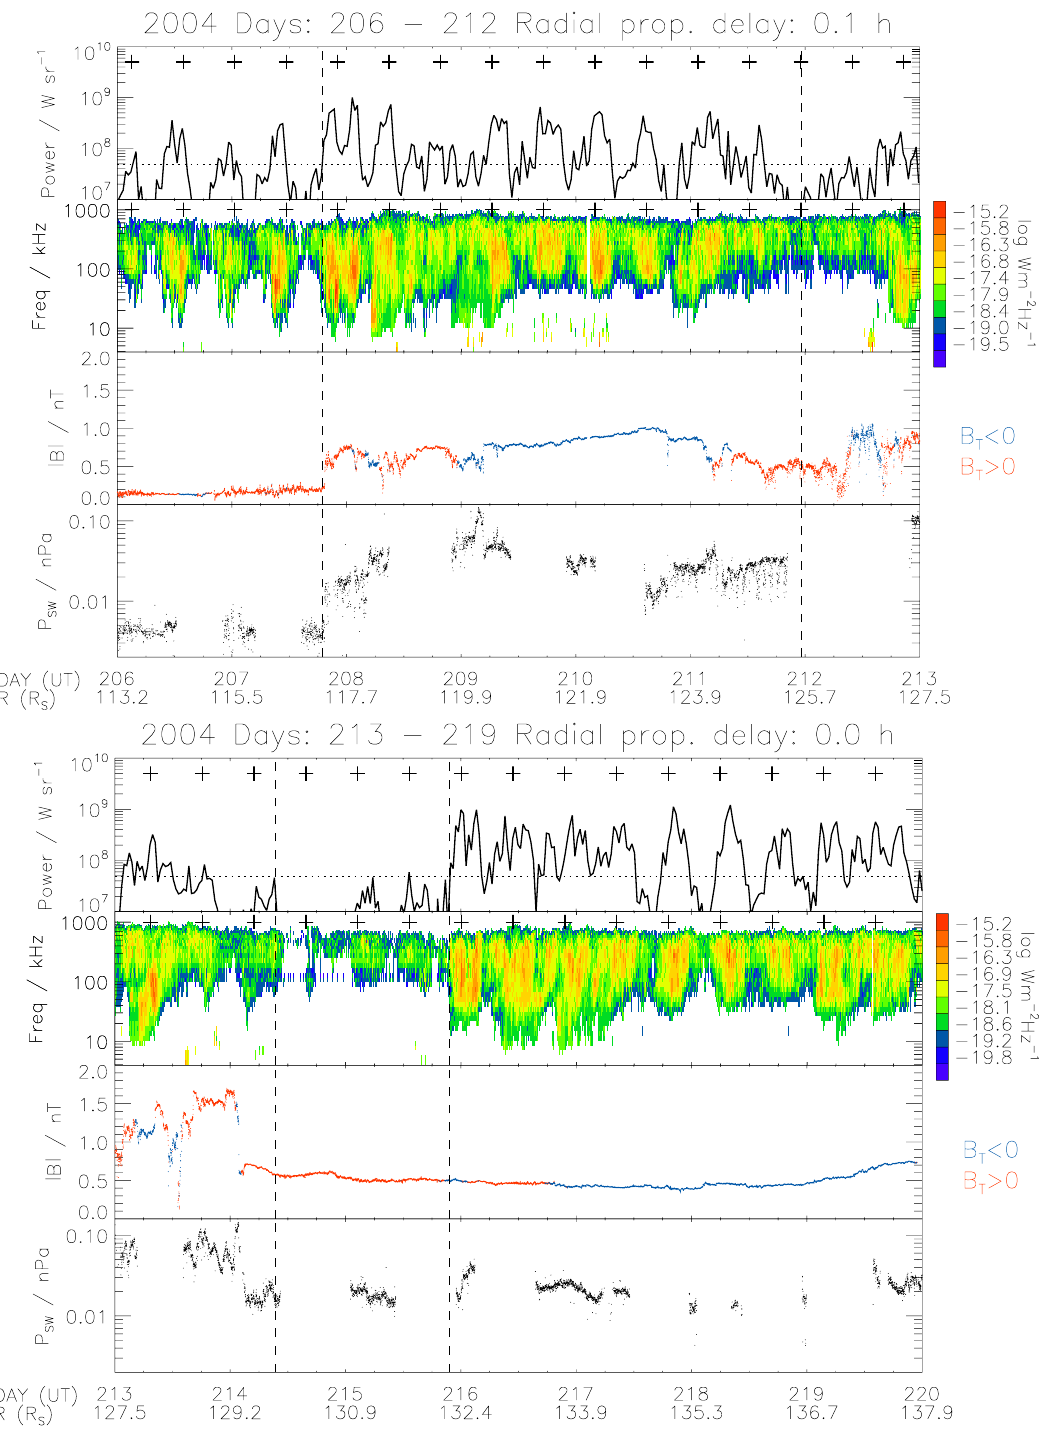
Fig. 3. SKR and IMF data from (a) days 206–212, and (b) days 213–219 of 2004. The data in the top three panels are in the same format as Fig. 1. The SKR power data in the top panel are 0.539056h averages. The bottom panel shows the solar wind dynamic pressure in nPa calculated from CAPS ion